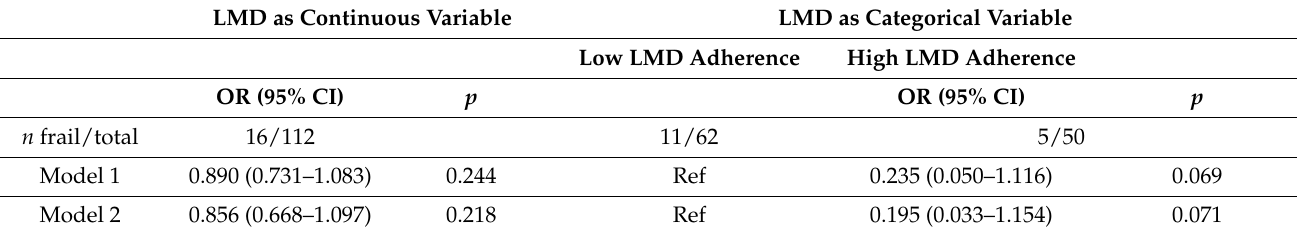
Table 3. Association between LMD adherence and frailty prevalence among Lebanese community- dwelling older